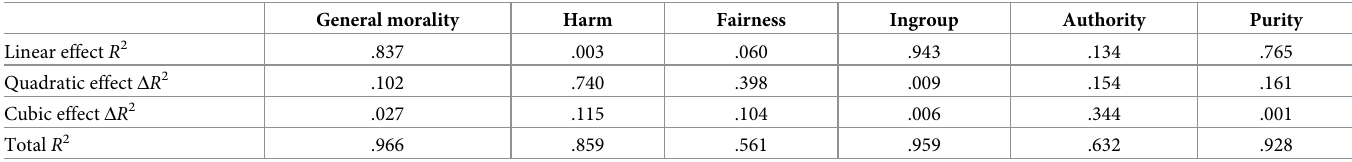
Table 2. Summary of curve-fitting analyses for the six moral dictionary time